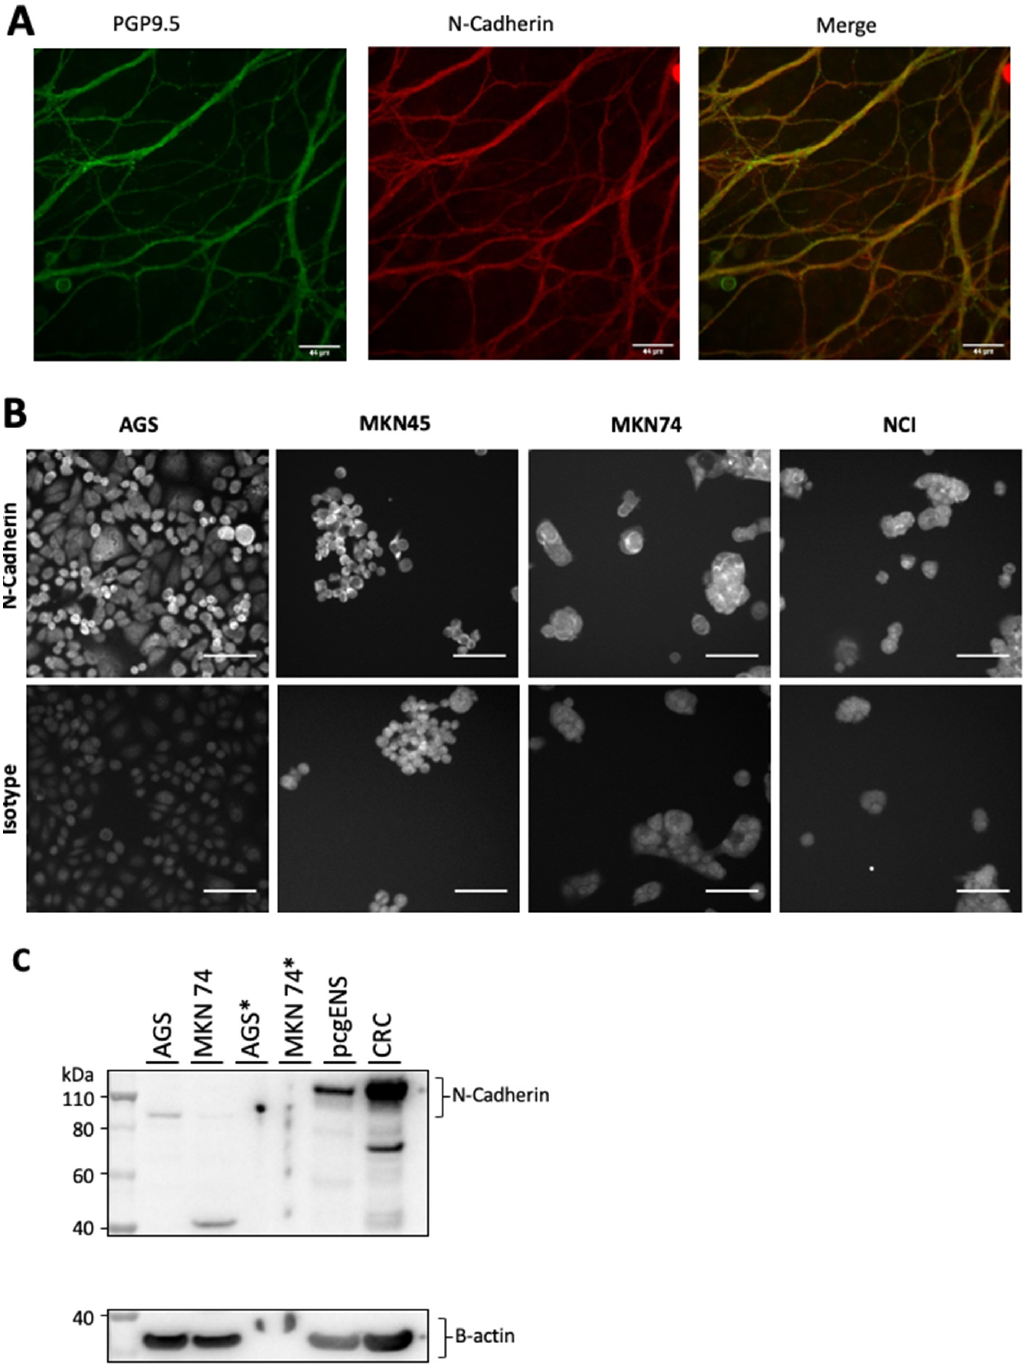
Figure 3. Expression of N-Cadherin in the enteric neurons of the pcgENS and in gastric cancer cell lines. Immunostaining of N-Cadherin using anti-N-cadherin in the enteric neurons of pcgENS ( A ) and in different gastric cancer cell lines ( B ) (scale-bar = 50 µ m). Analysis by Western blot of N-Cadherin expression in gastric cancer and CRC cell lines (B-actin used as positive control) ( C ). pcgENS—primary culture of enteric nervous system; CRC—colorectal cancer (human); *—ultracentrifugation protocol. The uncropped Western blots have been shown in Figure S3.